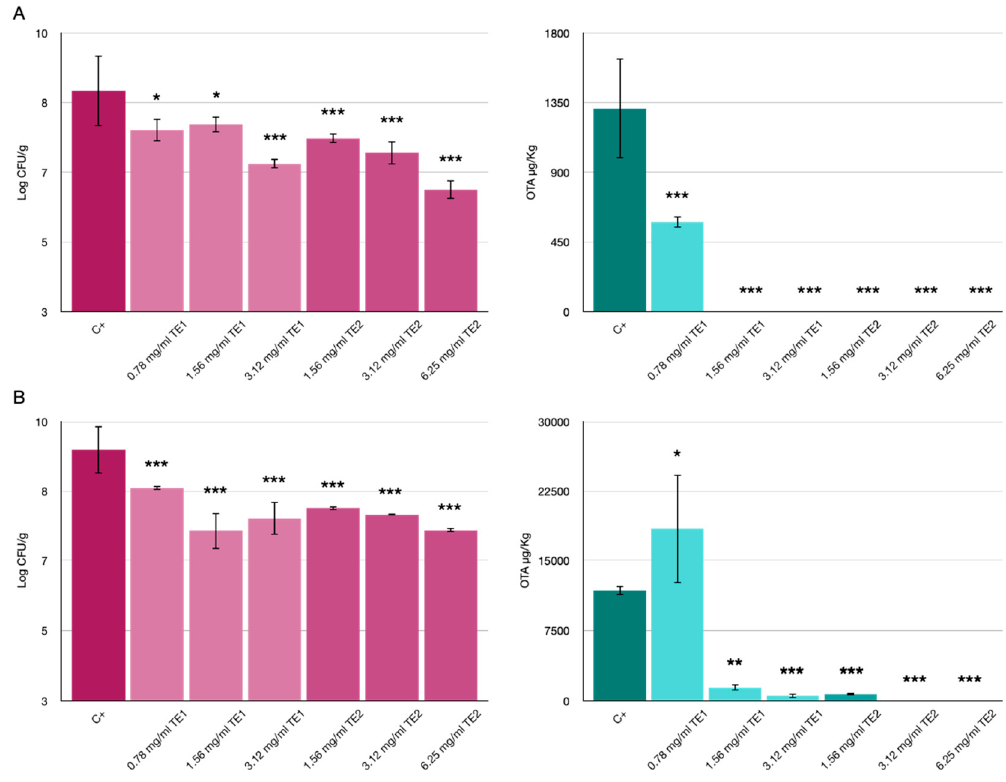
Figure 6. Effects of TE1 and TE2 on the growth of Penicillium verrucosum in wheat. Results expressed as microbiological count (log10 CFU/g) and OTA concentration detected (µg/Kg) at 10 days ( A ) and 20 days ( B ). Statistically significant differences for each treatment are indicated by * p < 0.05, ** p < 0.01, *** p < 0.001. Results are expressed as mean ± standard error.